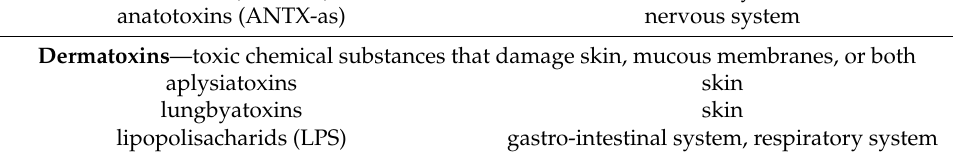
Table 2. Cyanobacterial toxins and primary organ targets, due to [147,148] with modifications). Toxins Primary Organ Targets Hepatotoxins —toxic chemical substances that damage the liver microcystins (MC) liver nodularins (NOD) liver Cytotoxins —toxic chemical substances that damage cells cylindrospermopsins (CYN) liver, kidney, spleen, intestine, heart, thymus Neurotoxins —toxic chemical substances destructive to nerve tissue anatoxins (ANTX-a) nervous system anatotoxins (ANTX-as) nervous system Dermatoxins —toxic chemical substances that damage skin, mucous membranes, or both aplysiatoxins skin lungbyatoxins skin lipopolisacharids (LPS) gastro-intestinal system, respiratory